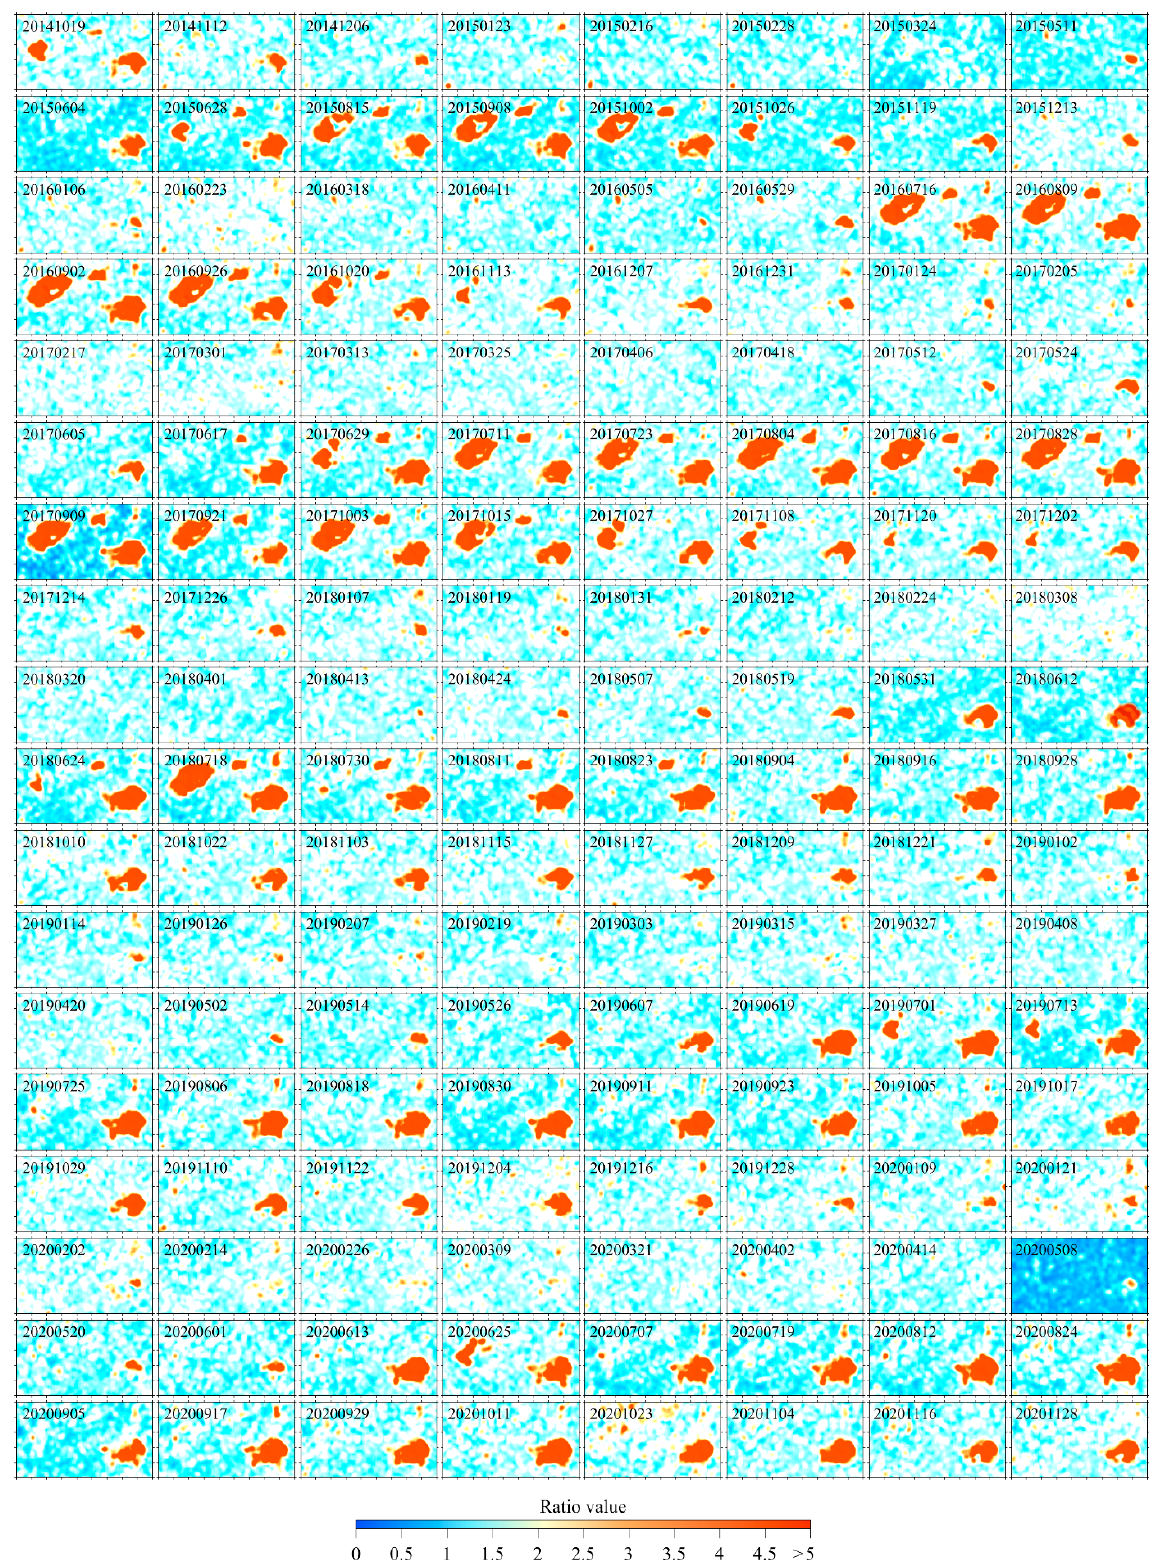
Figure 6. The 144 ratio maps derived from the 144 Sentinel-1 A SAR images based on the proposed method. The upper left corner of each sub-figure shows the date when the corresponding SAR image was acquired, in the format of “yyyymmdd”. The color bar indicates the ratio level ranging from 0 to 5, noting that the values greater than 5 are also colored with the same exponent as 5. The region with a high ratio level represents the water surface.